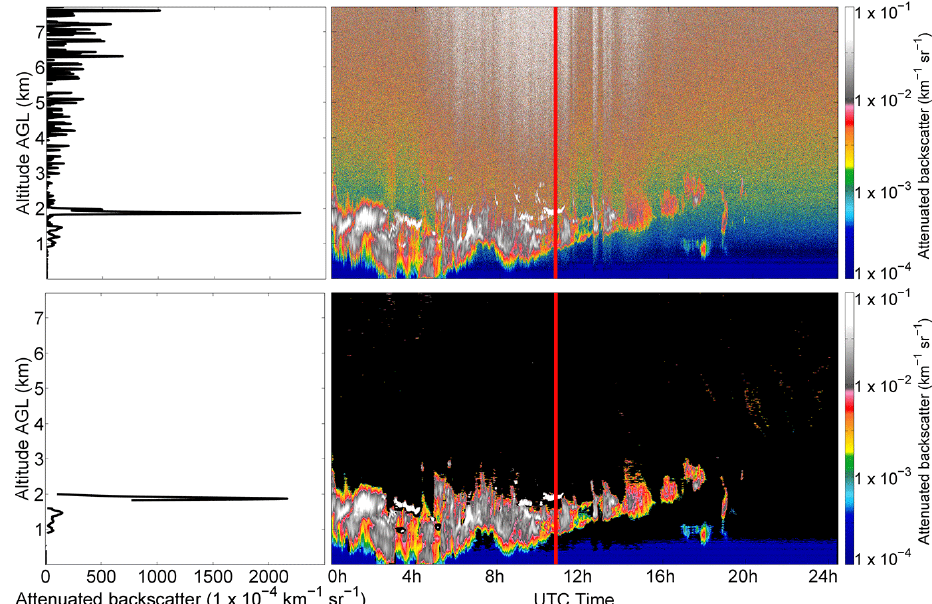
Fig. 3. Ceilometer attenuated backscatter (km − 1 sr − 1 ) at PE (14 March 2011) with example profile, indicated by the red line, before (top) and after (bottom) noise reduction and averaging procedures. Negative noise values are not shown in the left figures. Range bins where the SNR < 1 are not shown in the lower left image and are plotted in black in the lower right